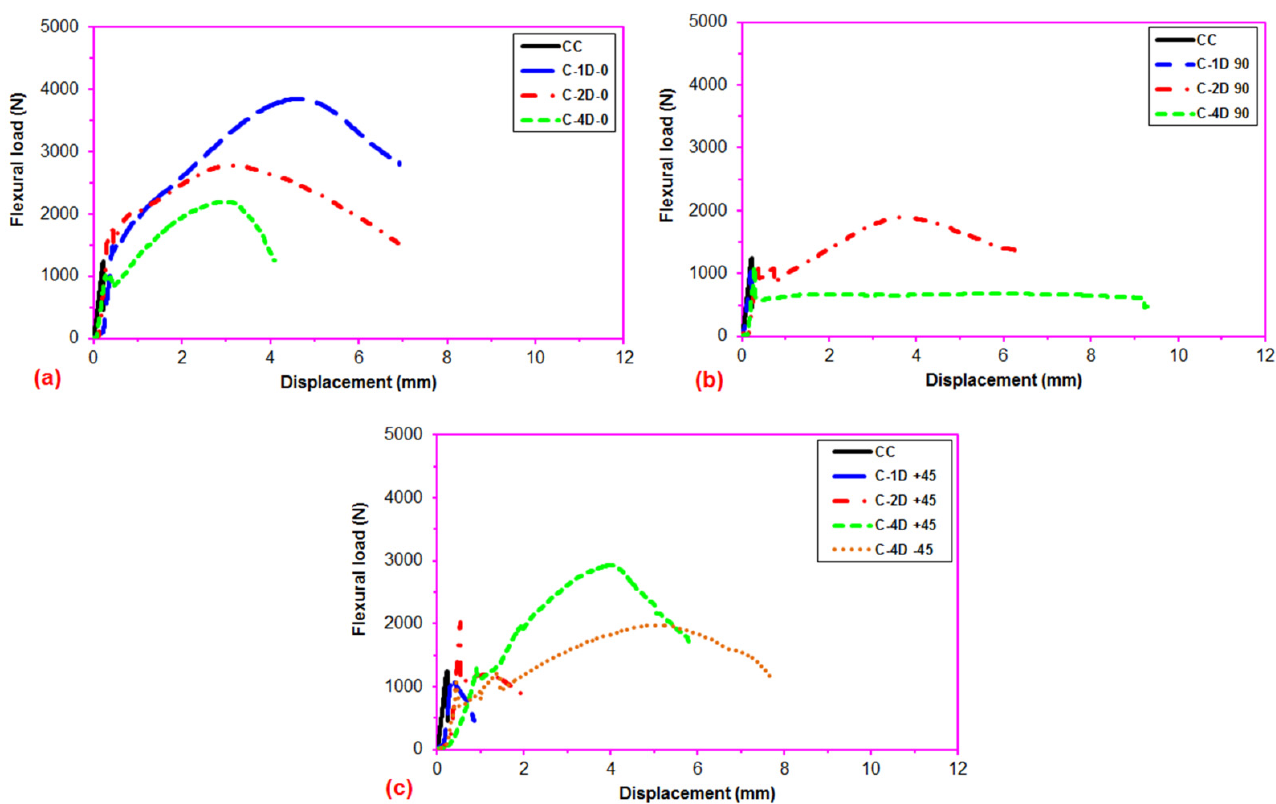
Figure 6. Flexural load-displacement curves of the multiaxis 3D carbon fiber concrete. ( a ) Various carbon TOW concrete structures at 0 degrees flexural test; ( b ) various carbon TOW concrete structures at 90 degrees flexural test; and ( c ) various carbon TOW concrete structures at bias directions flexural test.